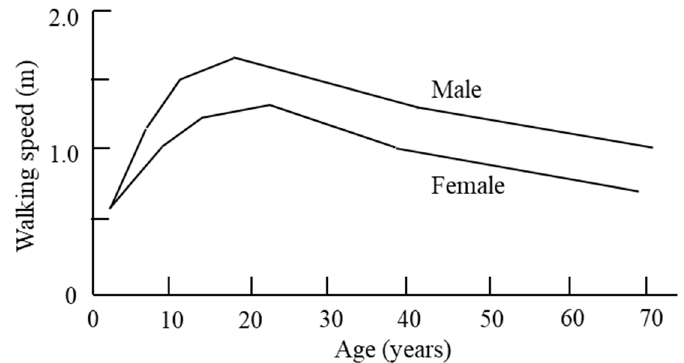
Figure 1. Gait speed graph by age and gender. Table 1. Constants for Equation, Evacuation Speed. Exit Route Element